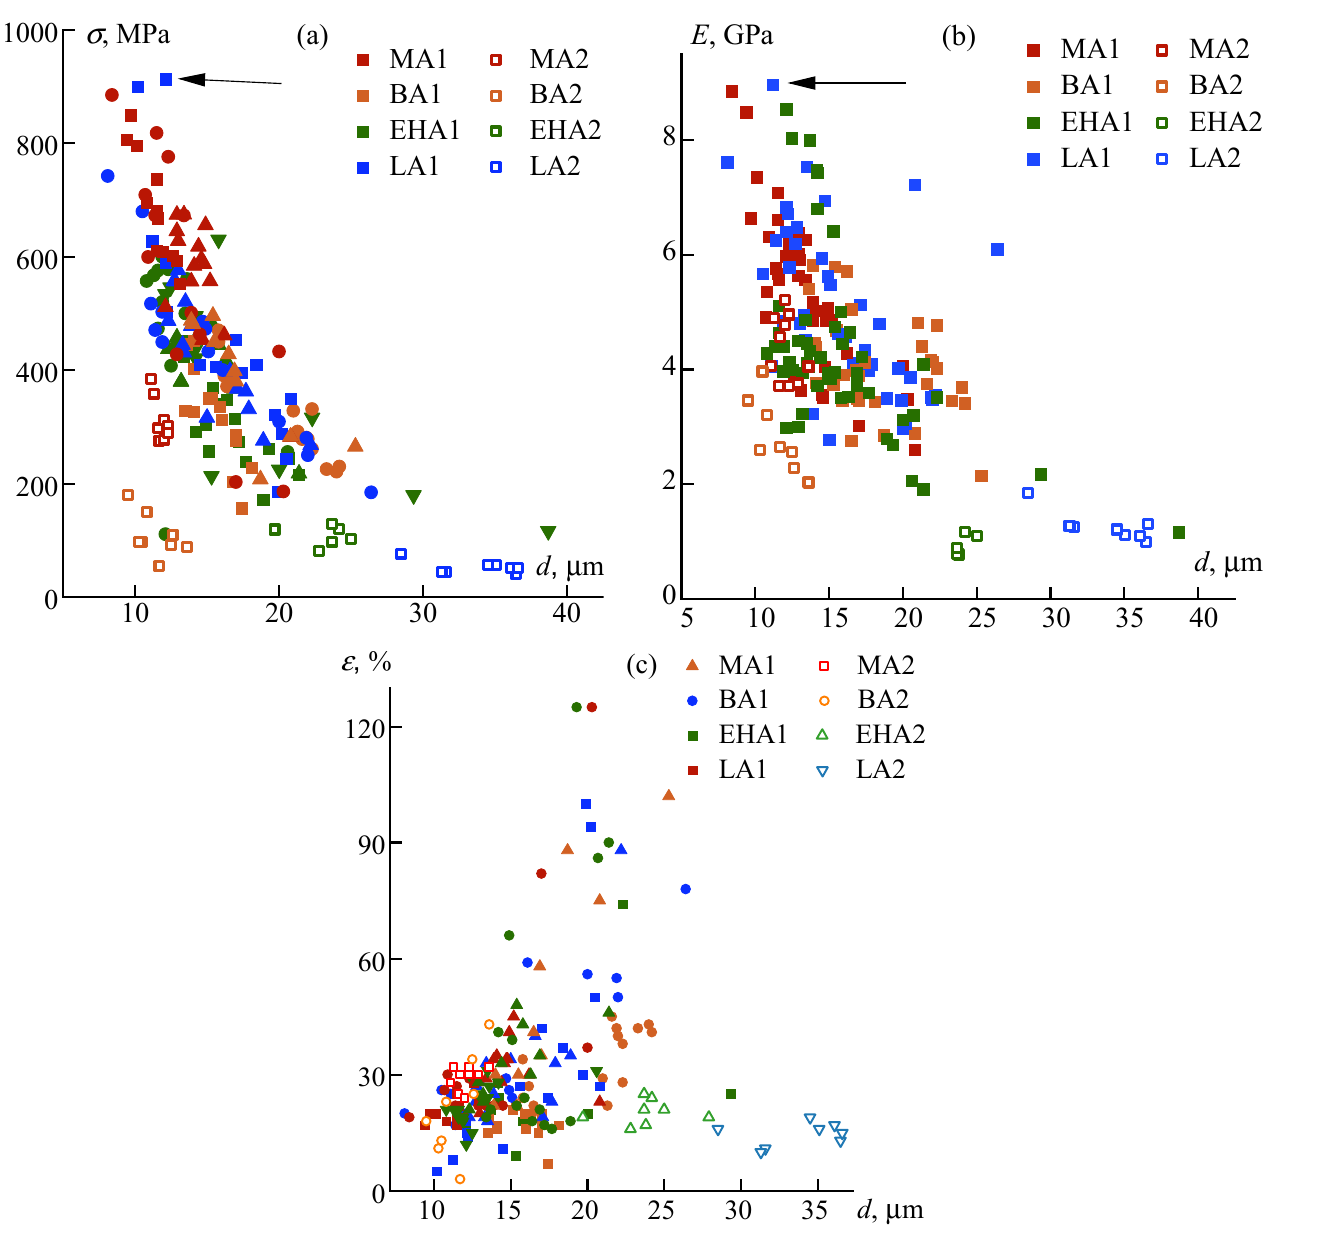
Figure 11. Dependences of strength ( a ); elastic modulus ( b ); and elongation at break ( c ) on fiber diameter.